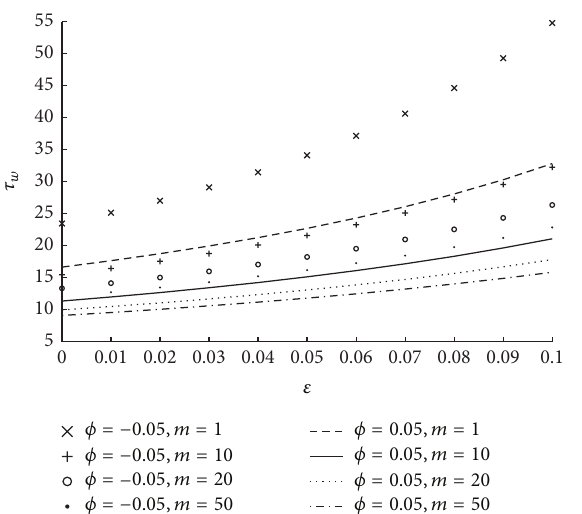
Figure 10: The variation of shear stress at wall with respect to 𝜙, 𝑚 at 𝑧 𝐿 when 𝑁 = 0.75 , 𝑟 𝑐 = 0.1 , and 𝑢 = 0.01 .